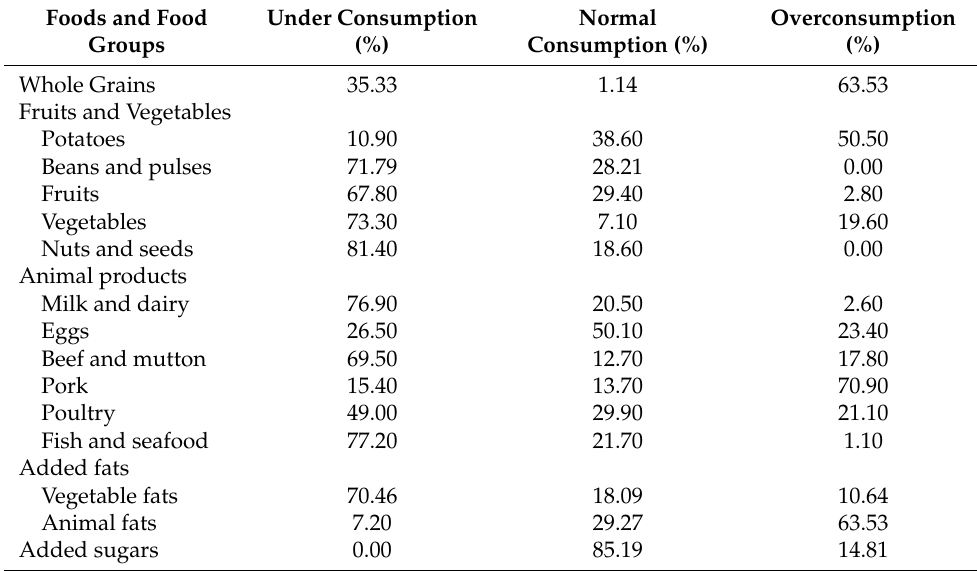
Table 2. Percent of respondents classified by consumption behavior, per food